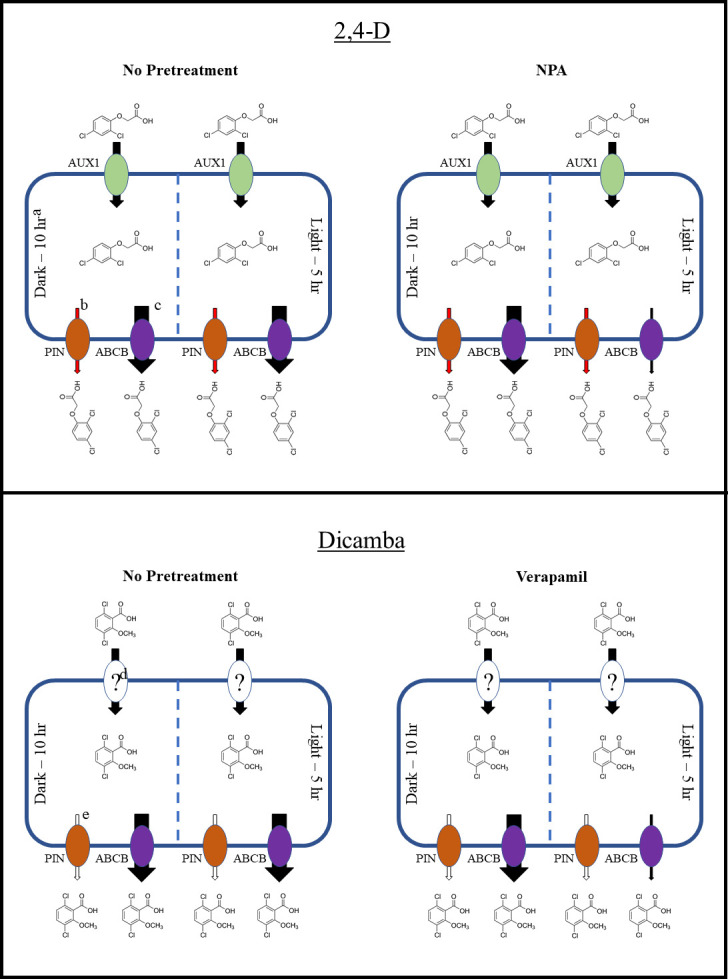
Diagrams illustrating differences in 2,4-D and dicamba efflux from plant cells across application times with no pre-treatment and NPA and verapamil pretreatment, respectively.aDark– 10 h indicates the 8 am, simulated dawn application, as applications were made after 10 h of darkness. Light– 5 h indicates the 1 pm, simulated mid-day application, as applications were made after 5 h of light. bRed arrows indicate probable 2,4-D efflux via PIN transport proteins. cSize of black arrows indicate magnitude of efflux via ABCB proteins. dQuestion mark indicates unknown influx carrier, if any, of dicamba. eWhite arrows indicate unknown extent, if any, of dicamba efflux via PIN proteins.